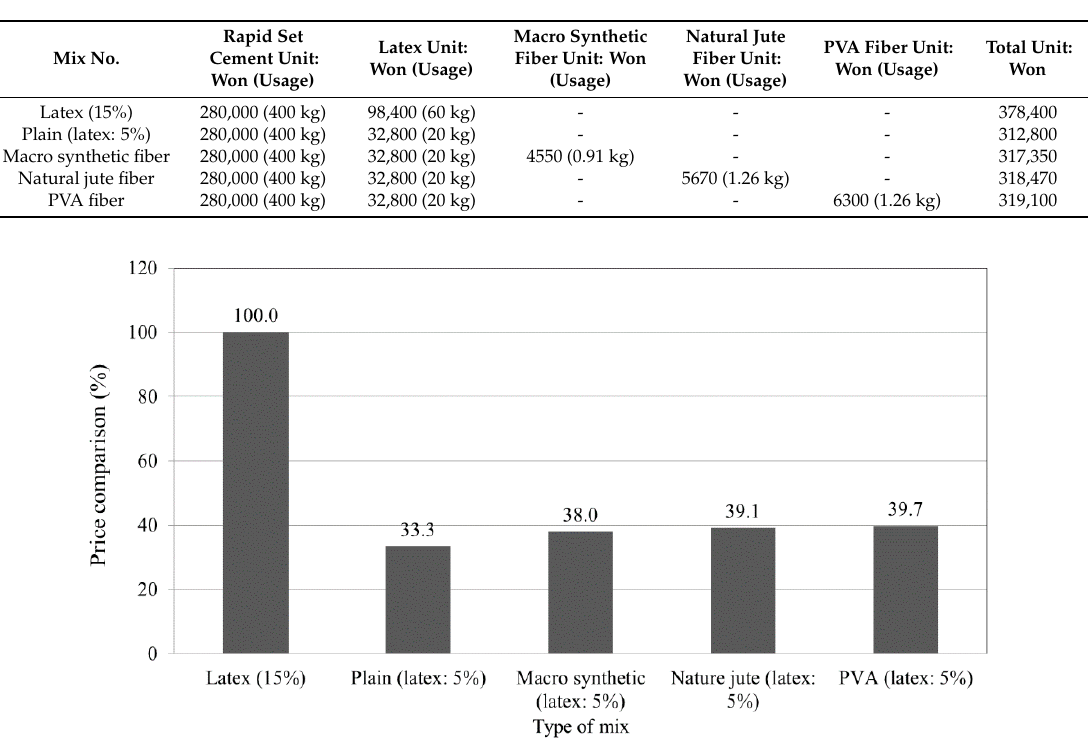
Figure 13. Comparing the cost reductions of a mixture of materials for repairing pavement.